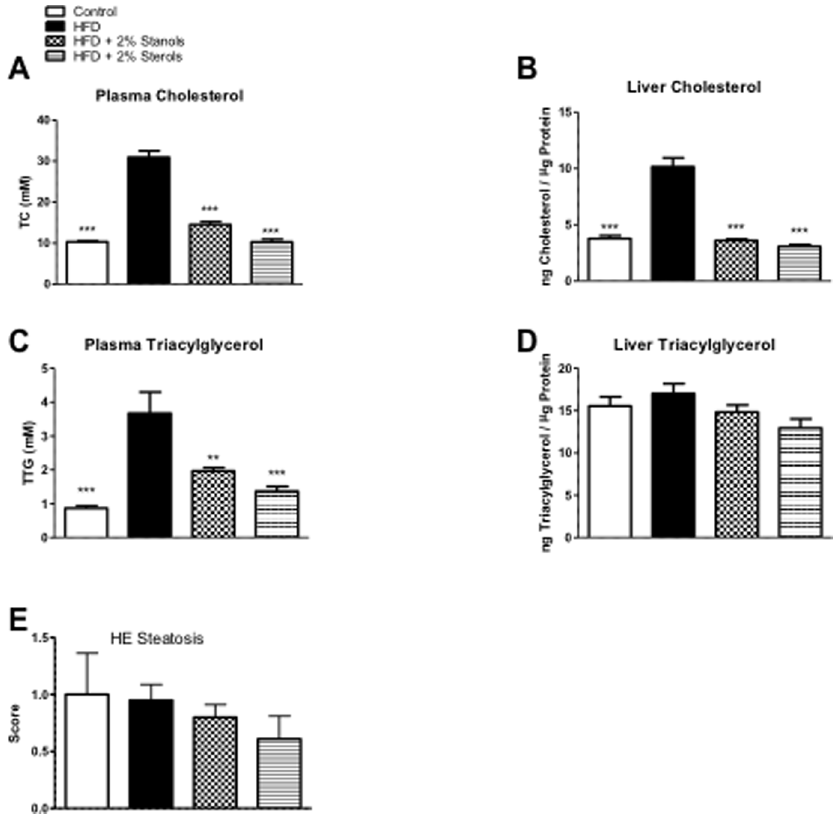
Figure 4. Lipid Measurements. (A, B) Plasma and liver cholesterol measurements. (C, D) Plasma and liver triacylglycerol levels. (E) Scoring of liver slides for the accumulation of fat (steatosis) using HE staining. A score ranging from 0–3 (3=highest steatosis) was given by an experienced pathologist. *P , 0.05, **P , 0.01, and ***P , 0.001, respectively.